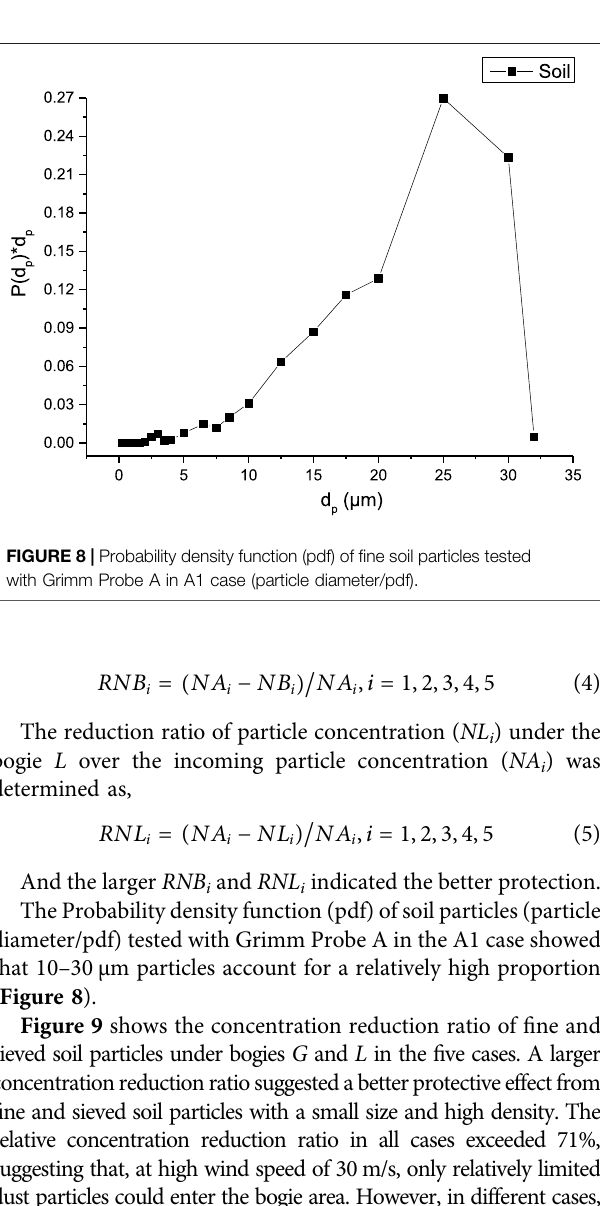
Frontiers in Earth Science |